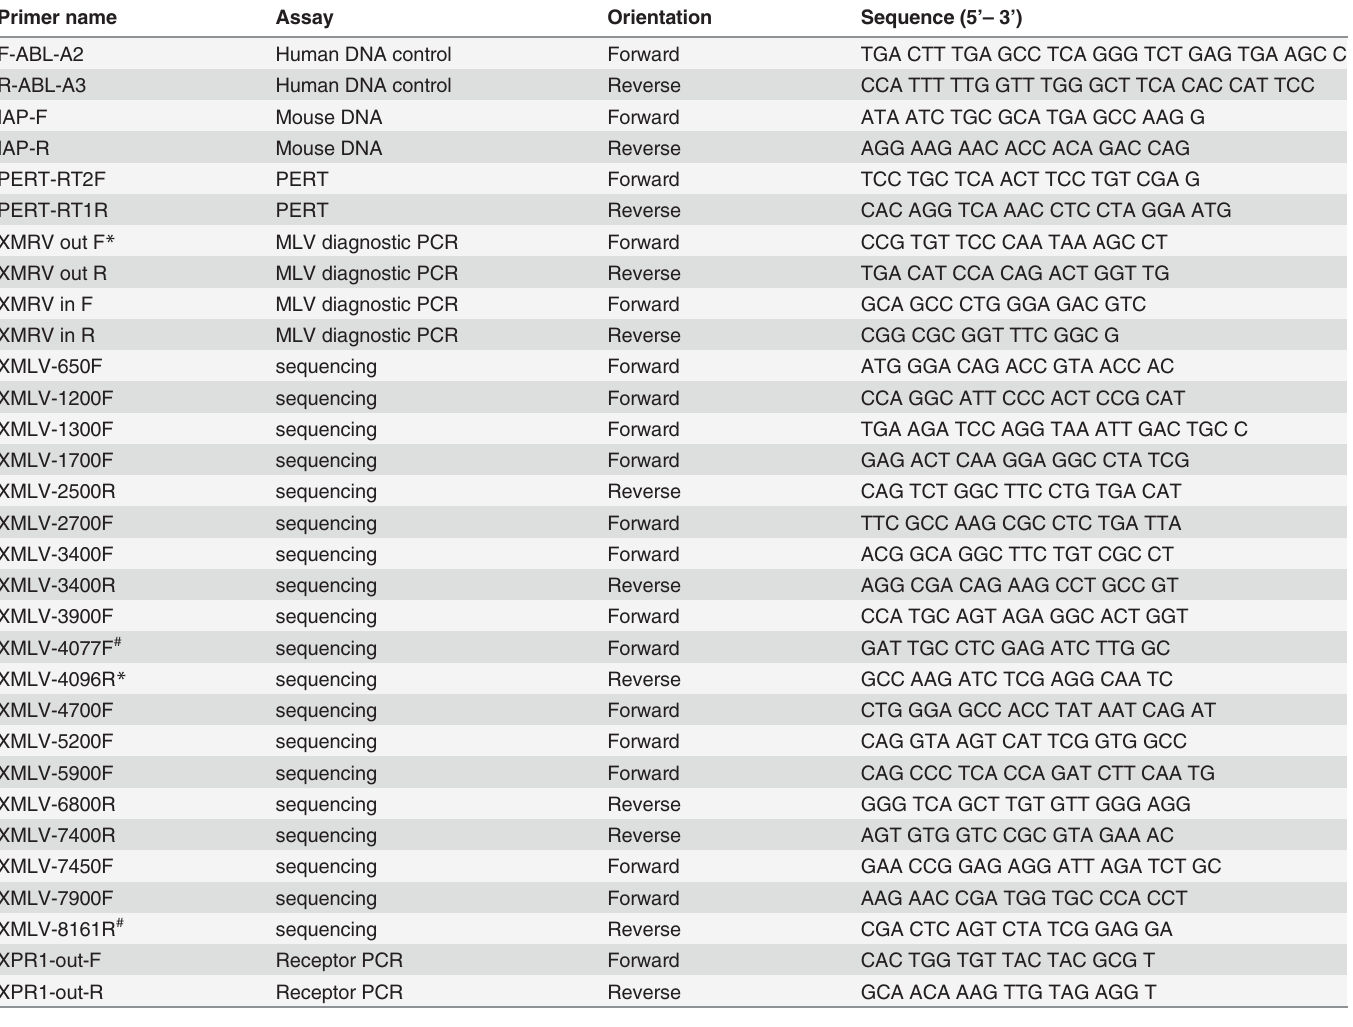
* Primers used for preparing 5´-half of the MLV genome for sequencing # Primers used for preparing 3´-half of the MLV genome for sequencing reproducible PCR run are the following conditions for both reactions of the nested PCR: the PCR mixture contained 100 μ M of each dNTP, 0.4 μ M each of forward and reverse primers, 1 x PCR buffer as recommended by the manufacturer of the Taq polymerase, 5% formamide and 1 U TaKaRa HS Taq polymerase (Lonza, Verviers, Belgium). One μ l genomic DNA was added at last. The Taq polymerase was activated by heating the mixture for 2 min at 96°C. The DNA amplification was carried out for 35 cycles with 4 s at 96°C denaturation, 8 s at 60°C annealing, 15 s plus 1 s per cycle at 72°C extension, and 10 min at 72°C as final extension at the end of the PCR. The nested PCR with the inner primers was carried out employing the same parameters, except that 1 μ l of the first round PCR mixture was added instead of the genomic DNA and the PCR was run for only 30 cycles. Positive, negative, and water control reactions were included in every PCR run.